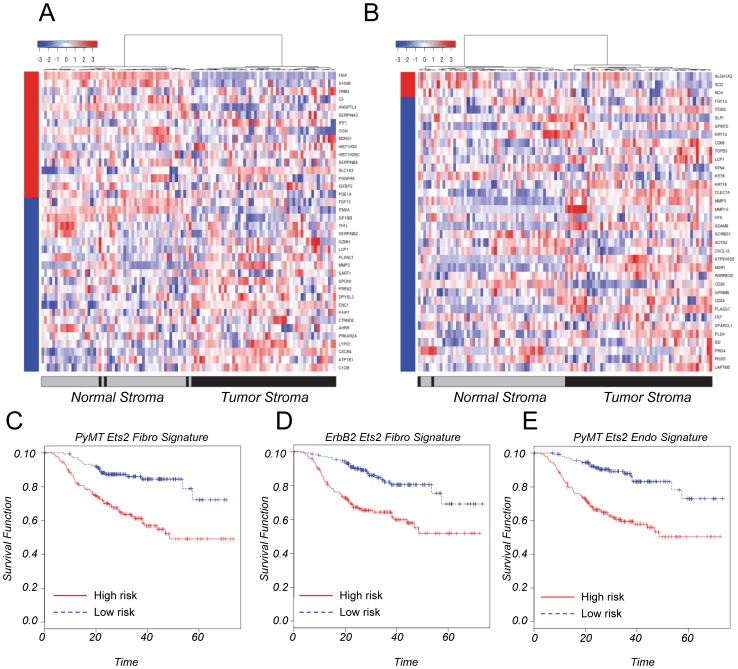

Ets2 gene signatures are represented in human breast tumor stroma.
A. Heat map displaying the expression of the human orthologs of the PyMT derived 38-gene Ets2 signature in normal- and tumor-stroma from human breast cancer patients. 16 genes were upregulated (denoted by red bar on the y-axis) and 22 genes were downregulated (denoted by the blue bar on the y-axis) in Ets2 null tumor fibroblasts. Red and blue regions inside the heat map indicate relative gene expression levels (red, increased and blue, decreased) between the normal and tumor stroma (P = 0.00085, one-sided Wilcoxon rank sum test, based on 10,000 permutations). B. Heat map displaying the expression of the human orthologs of the ErbB2 derived 36-gene Ets2 signature in normal- and tumor-stroma from human breast cancer patients. 3 genes were upregulated (denoted by red bar on the y-axis) and 33 genes were downregulated (denoted by the blue bar on the y-axis) in Ets2 null tumor fibroblasts. Red and blue regions inside the heat map indicate relative gene expression levels (red, increased and blue, decreased) between the normal and tumor stroma (P = 0.00004, one-sided Wilcoxon rank sum test, based on 10,000 permutations). C. Expression of the 29 PyMT-driven Ets2-dependent genes present in the NKI whole tumor data set correlates with patient outcome. Kaplan-Meier curves of high risk and low risk groups based on expression of the 29 Ets2 tumor specific genes (**P<0.0001). D. Expression of the 30 ErbB2-driven Ets2-dependent genes present in the NKI whole tumor data set correlates with patient outcome. Kaplan-Meier curves of high risk and low risk groups based on expression of the 30 Ets2 tumor specific genes (**P<0.0001). E. Expression of the 7 endothelial cell genes dependent on Ets2 fibroblast signaling present in the NKI whole tumor data set correlates with patient outcome. Kaplan-Meier curves of high risk and low risk groups based on expression of the 7 endothelial cell genes (**P<0.0001).